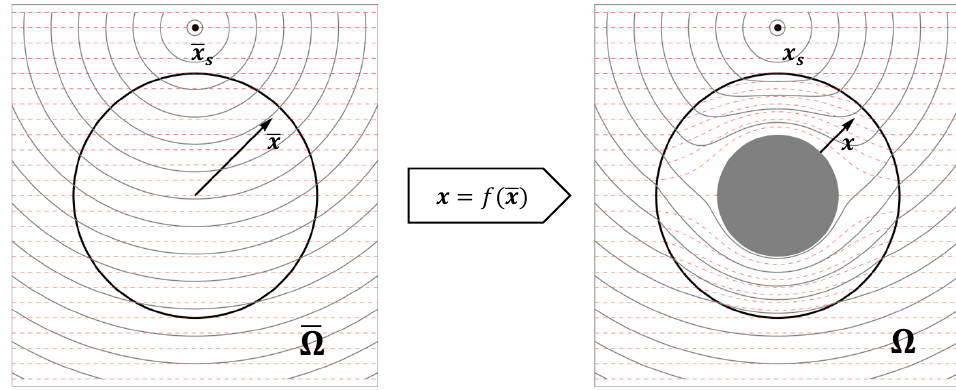
Figure 2. Effect of coordinate transformation on straight lines (red, dashed) and wave fronts (black, continuous lines) from the virtual domain ¯ Ω to the physical domain Ω . Object and source at